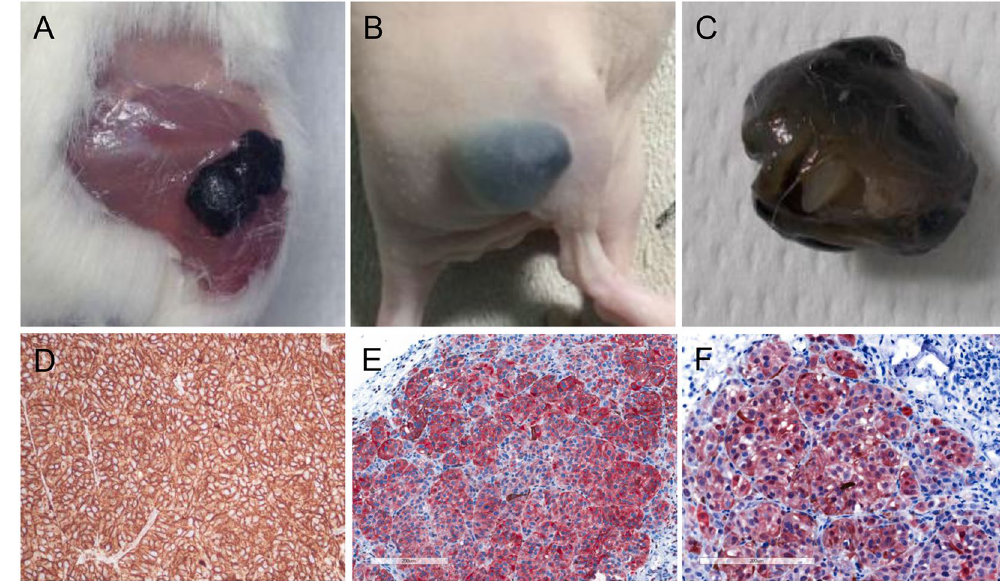
Figure 4. Tumorigenicity: MUG-Mel2 growing in NSG mice ( A ), black tumor was visible within 10 days ( B ). Separated tumor from nude mouse ( C ). IHC from xenotransplantations with strong HMB-45 expression ( D ), strong Melanin-A expression ( E ), and strong S-100 expression ( F